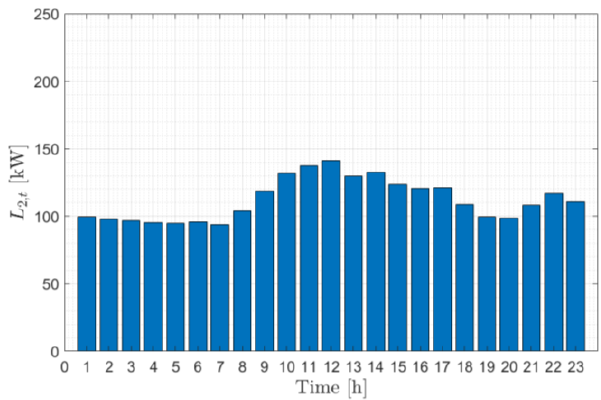
Figure 4. Renewable power production of the LUs.